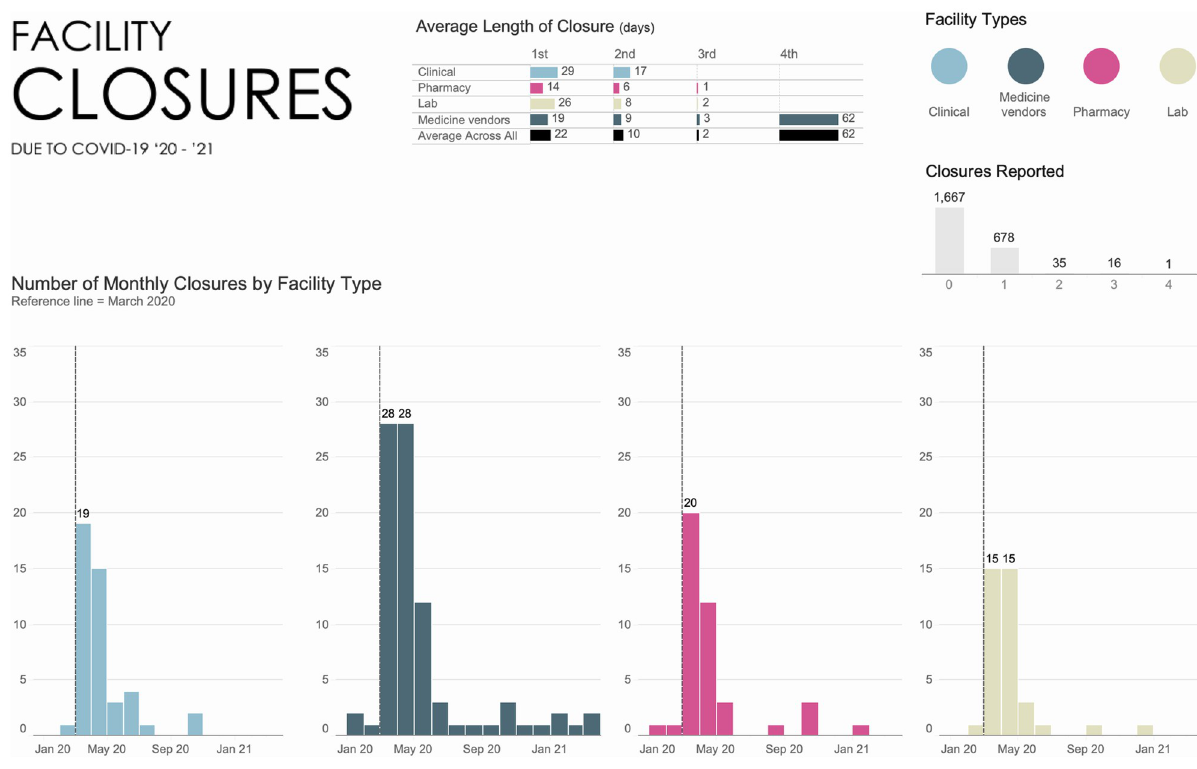
Fig 2. Facility closures due to COVID-19,